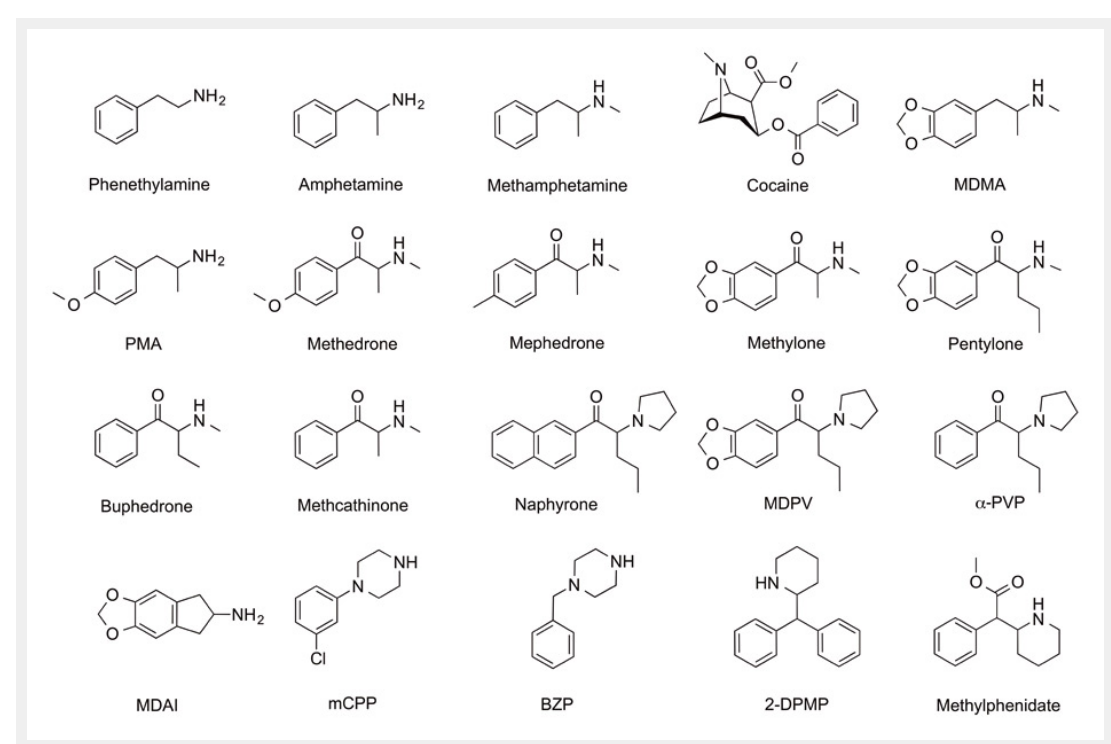
Structures of representative novel psychoactive substances (stimulants and empathogens). Chemically, the substances shown include amphetamines (amphetamine, methamphetamine, MDMA, PMA), cathinones (β-keto-amphetamines such as methedrone, mephedrone, methylone, pentylone, buphedrone, methcathinone, naphyrone, MDPV or α-PVP), an aminoindane (MDAI), piperazines (mCPP and BZP) and pipradrols (2–DPMP and methylphenidate). Pharmacologically, these substances are psychostimulants or empathogens and primarily interact with monoamine